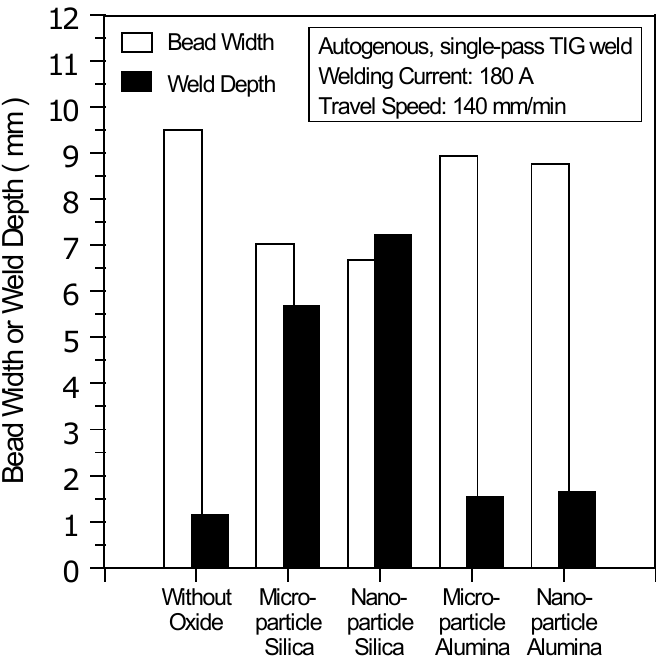
Figure 6. Geometric size of TIG welds made with and without